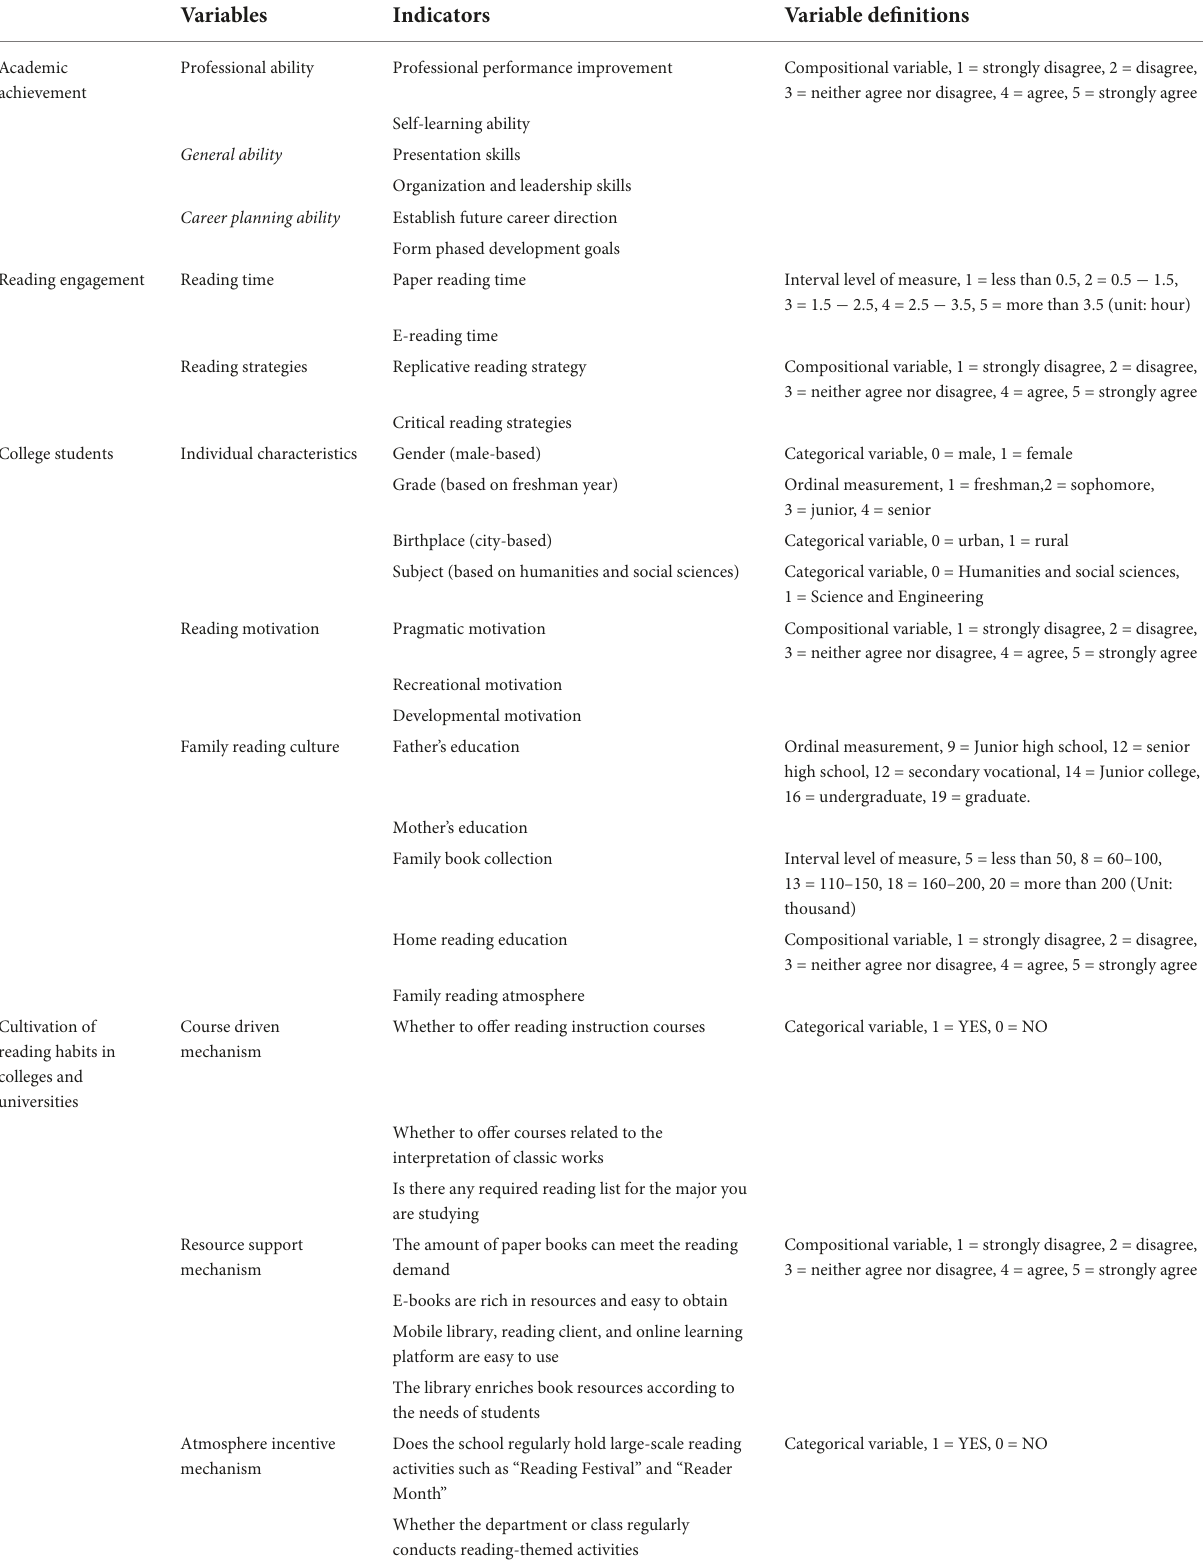
TABLE 2 Measurement of